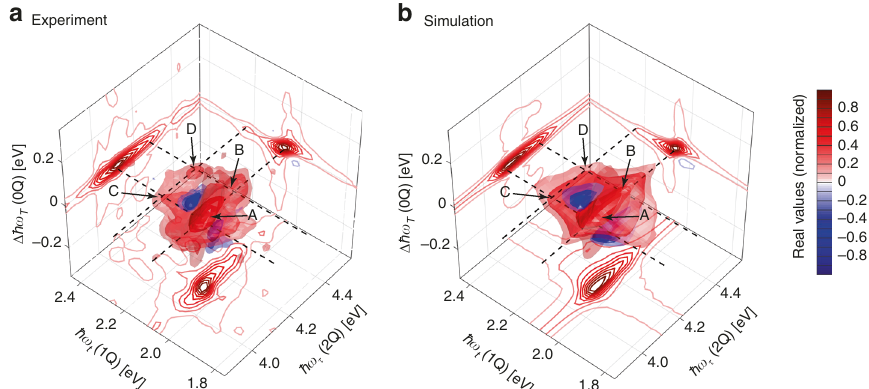
Fig. 5 Sixth-order 2Q – 0Q – 1Q three-dimensional (3D) spectrum (real part) of TIPS – TAP 2 − in THF. The 3D spectra shown are obtained by the sum of the rephasing and nonrephasing 2Q – 0Q – 1Q contributions. a Experimental and b simulated 3D spectra. Isosurfaces are drawn at − 12, − 10, − 7, 7, 11, and 35% of the normalized signal amplitude. Contour lines are drawn at 0.1 steps as indicated by the color bar. The bottom projections of the solids show the purely absorptive 2Q – 1Q 2D spectrum at T = 0 fs. The dashed lines in the Δ ℏ ω T = 0 plane denote the energies of the main absorption band at 2.06 eV and the progression band at 2.23 eV along ℏ ω t and the energies of the 2Q levels at 4.10 and 4.27 eV along ℏ ω τ . The letters A, B, C, D mark peaks, which are discussed in the article